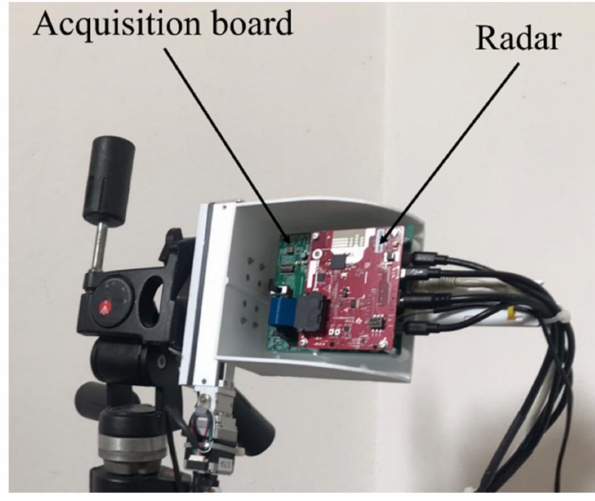
Figure 6. Prototype of interferometric